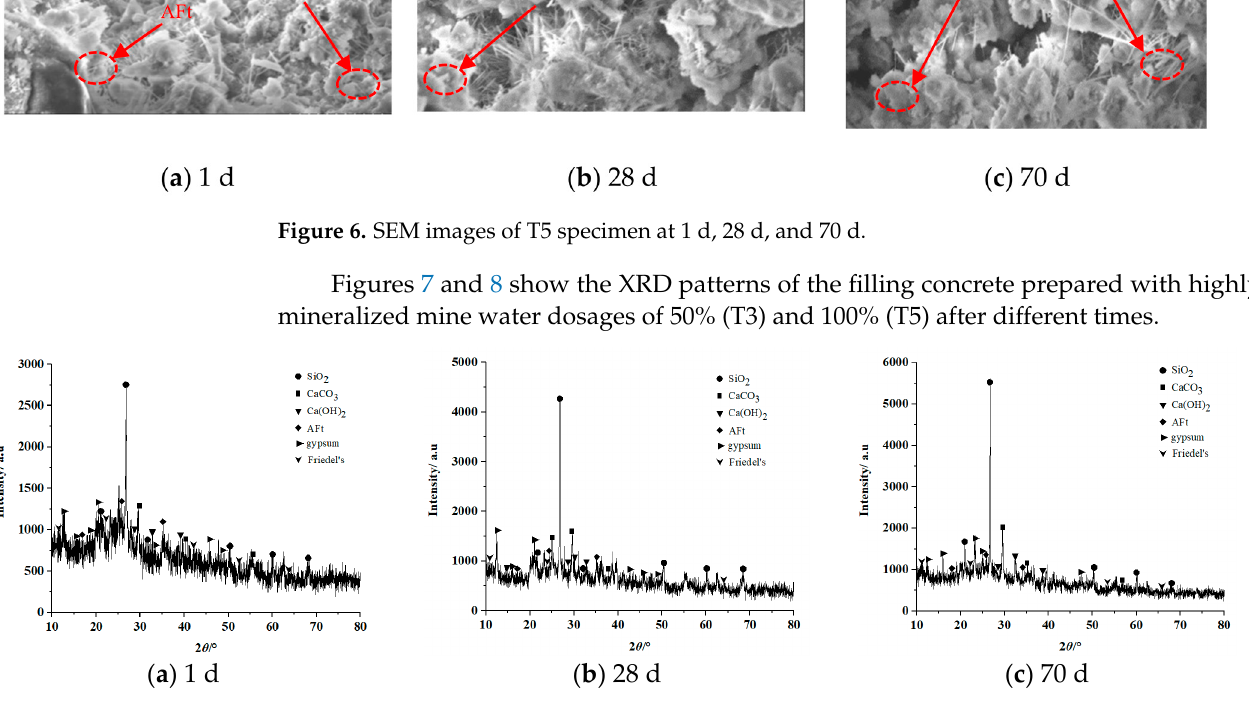
Figure 7. XRD patterns of T3 specimen at 1 d, 28 d, and 70 d. Figure 7 indicates that after curing for 1 d, the dominant hydration product in